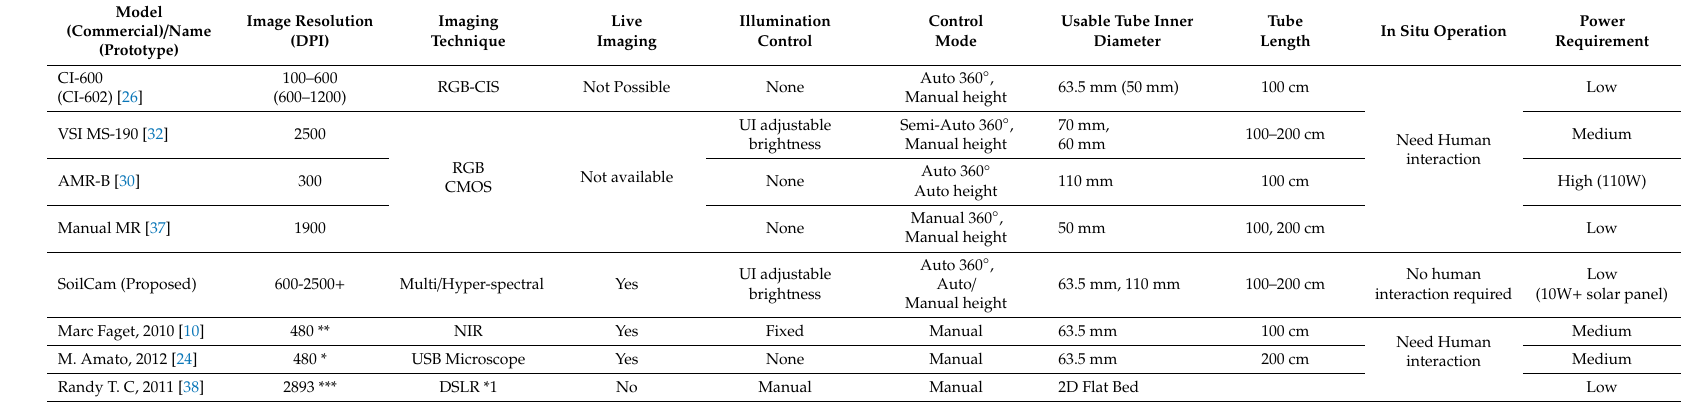
Table 5. Comparison of main features among the commercial, lab-prototype, and proposed